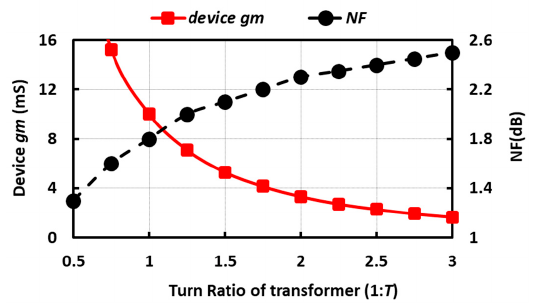
Figure 2. Simulation of required device gm and NF vs. T .